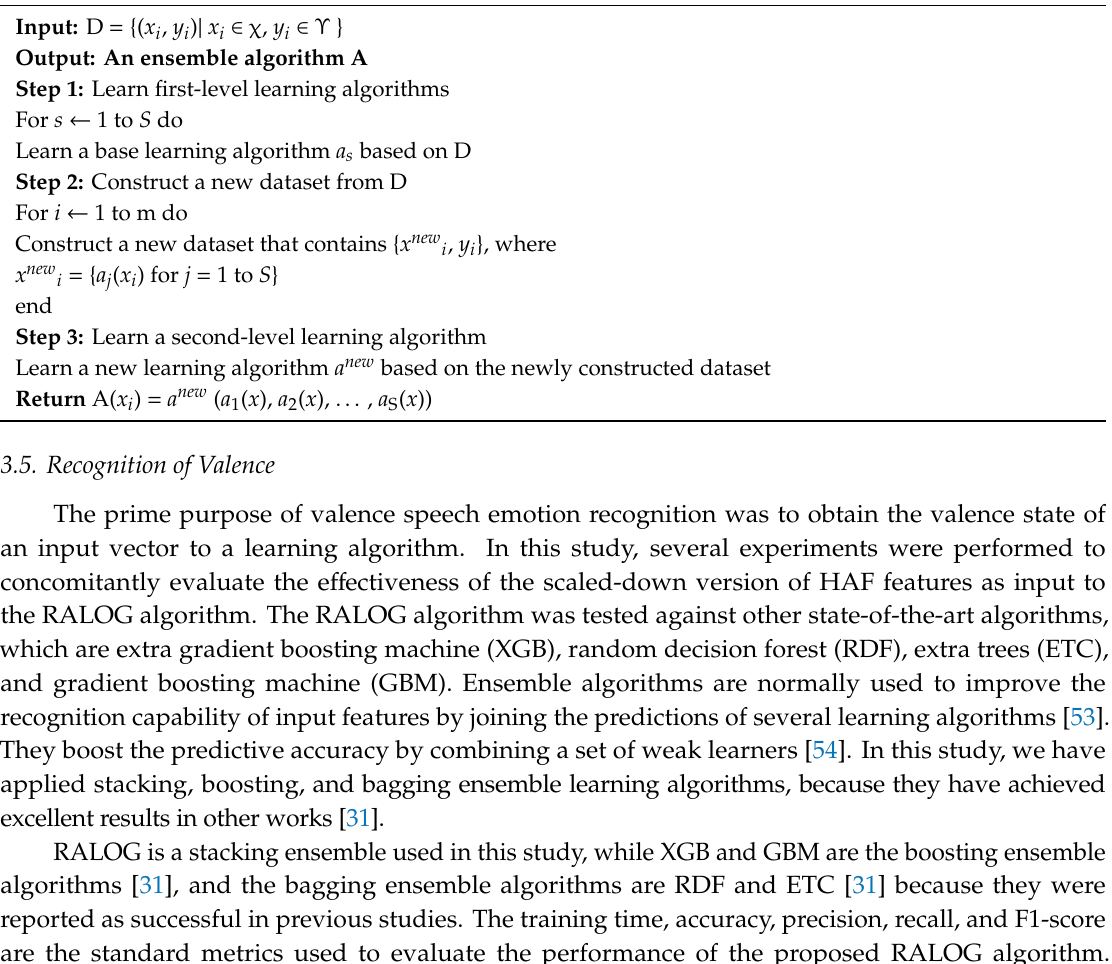
Algorithm 1: Stacking Ensemble